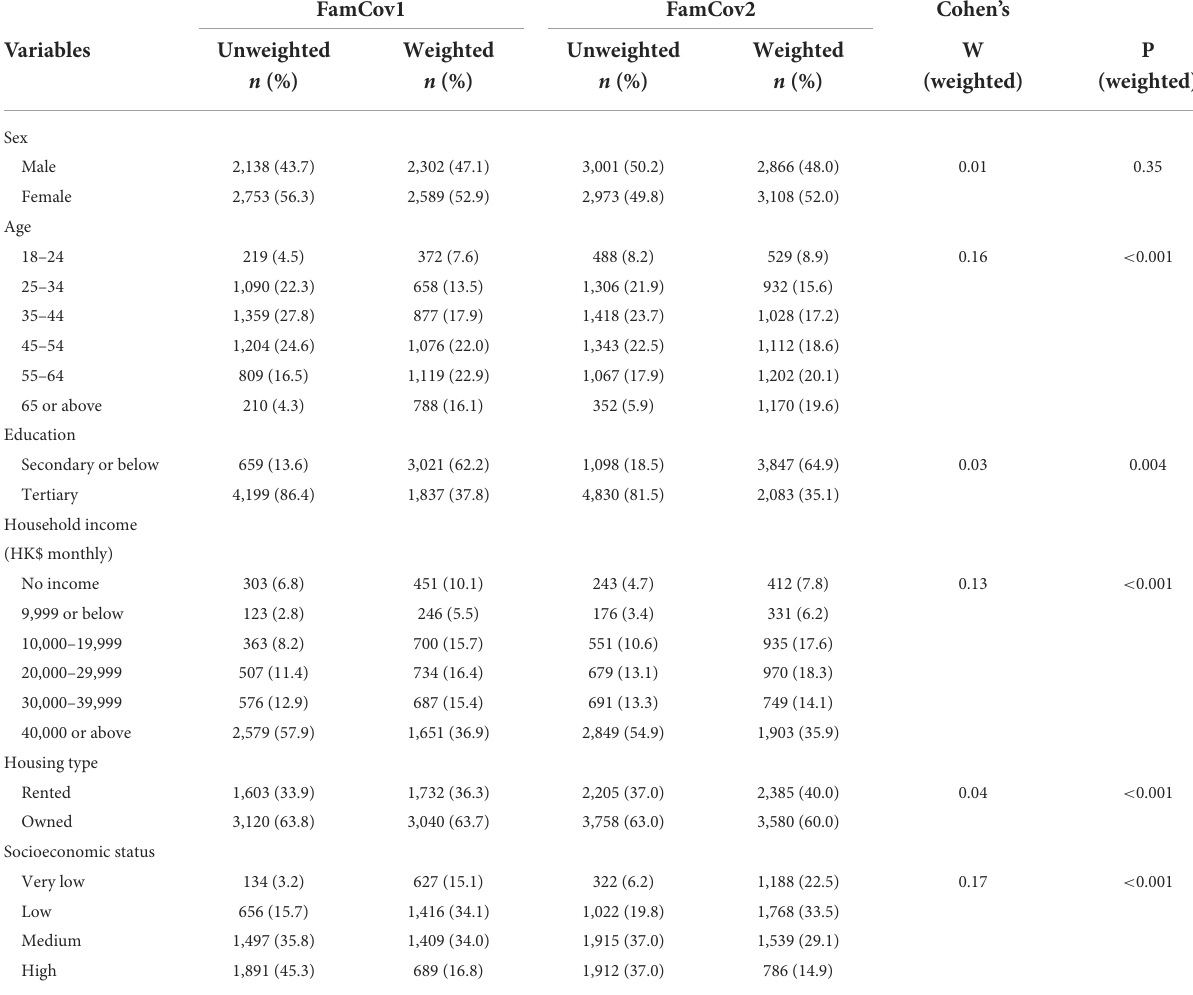
TABLE 1 Sociodemographic characteristics of participants of FamCov1 (May 2020) and FamCov2 (March 2021) surveys. FamCov1